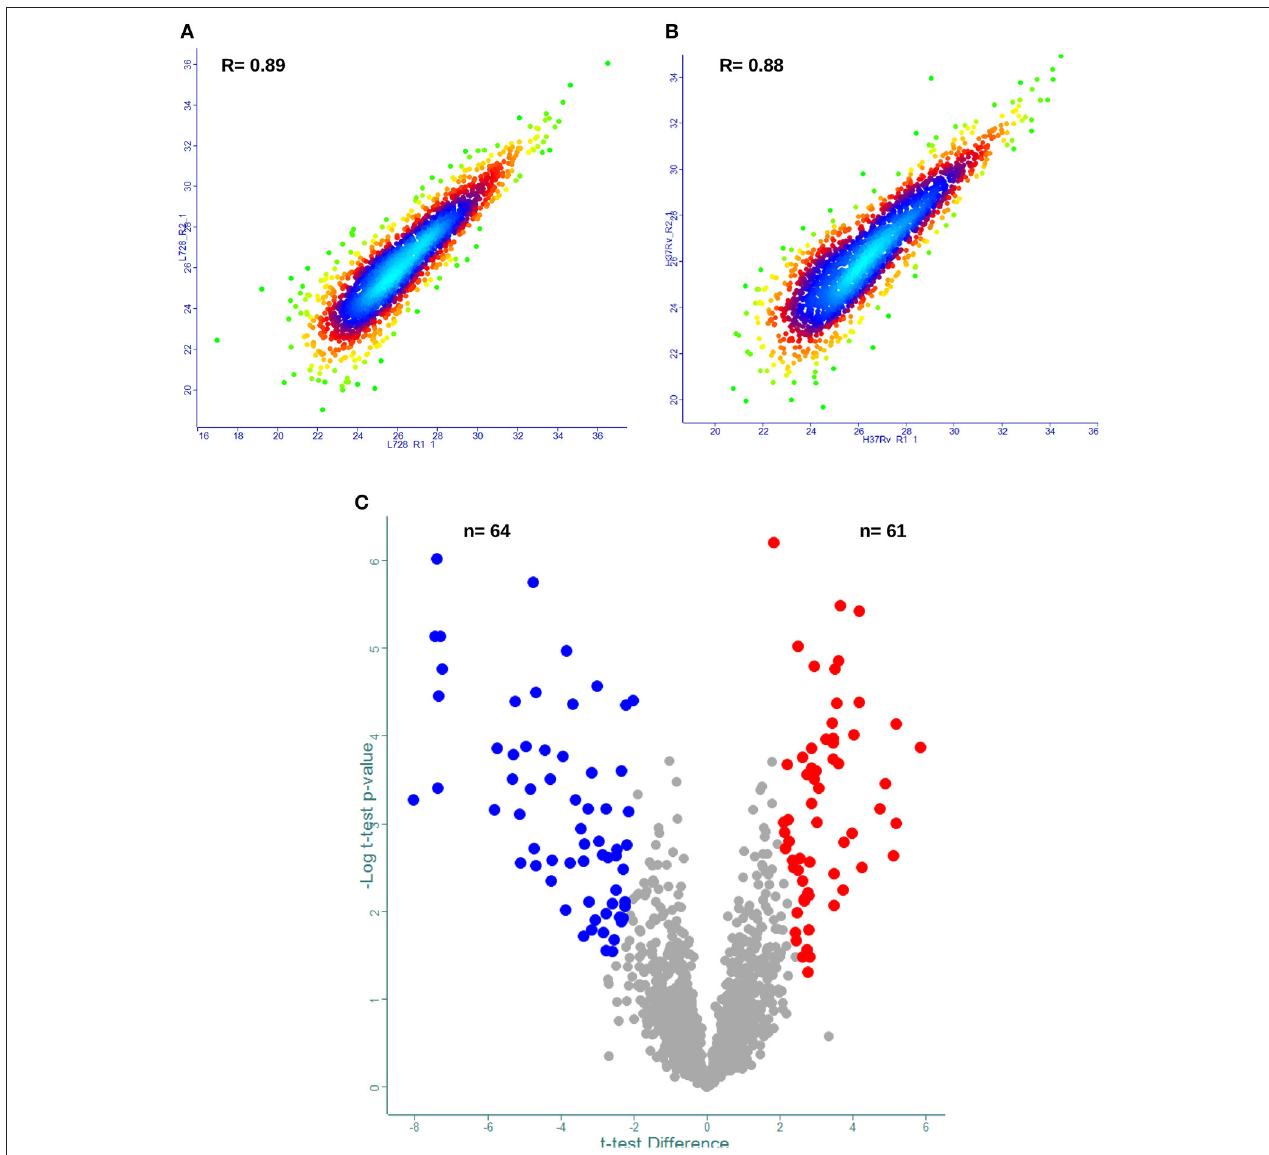
FIGURE 3 | Label free proteome quantification of Mycobacterium tuberculosis lineages. Quantitative analysis was performed using the MaxQuant and Perseus software environments as described in the method section. Reproducibility of the analytic workflow for biological replicates was assessed by Pearson correlation coefficients ( R -values). (A,B) Represent density scatter plot of peptide intensities for biological replicates of M. tuberculosis lineage 7 and lineage 4, respectively. (C) volcano plot of protein abundance differences as a function of statistical significance ( t -test p ≤ 0.05 and fold change cutoff point ± 2) between lineage 7 and lineage 4 isolates. Y-axis indicates p -value ( − log 10 ). X-axis shows protein ratio (x-axis) in lineage 7 vs. lineage 4 stains. The color code indicates upregulation (red) and downregulation (blue). Proteins with no statistically significant difference in abundances between the two lineages are shown in